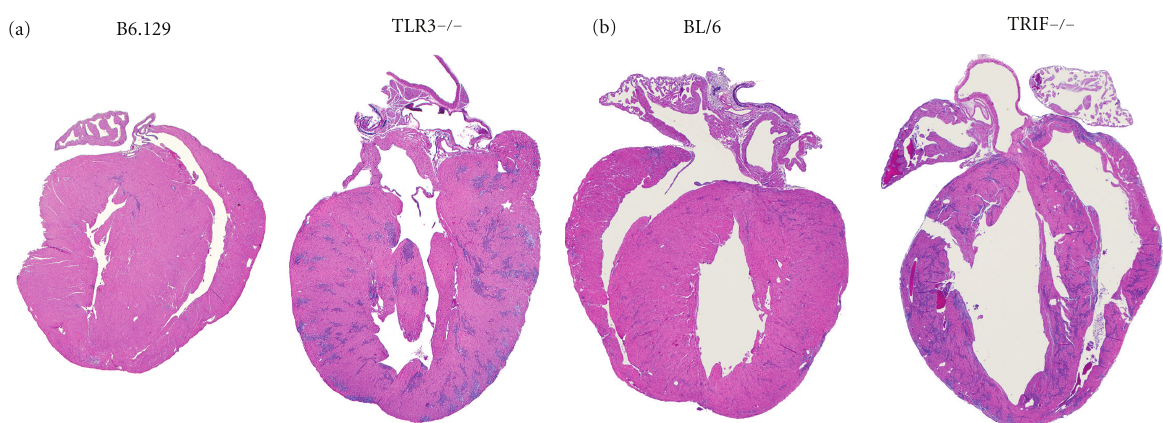
Figure 4: TRIF-deficient (TRIF − / − ) mice develop DCM by day 10 pi, but TLR3 − / − mice do not. Representative histology sections of (a) TLR3 − / − compared to WT B6.129 controls at day 10 pi, magnification × 5. (b) Representative histology sections displaying dilation in TRIF − / − compared to WT BL/6 mice at day 10 pi, magnification × 5.